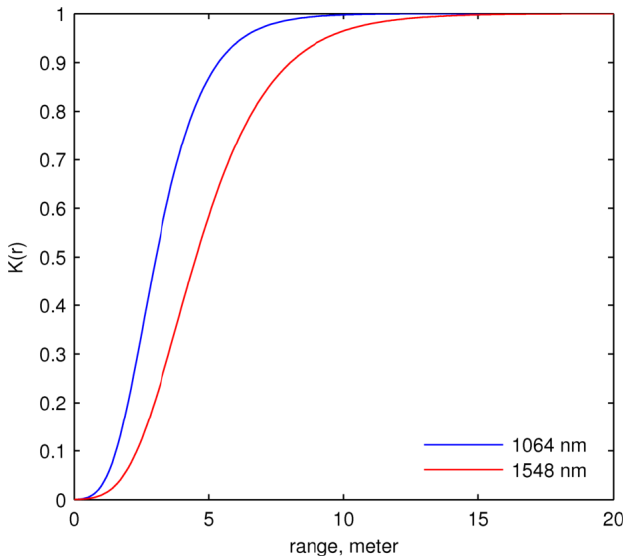
Figure 6. Telescope efficiency 𝐾(𝑟) of the two wavelengths.